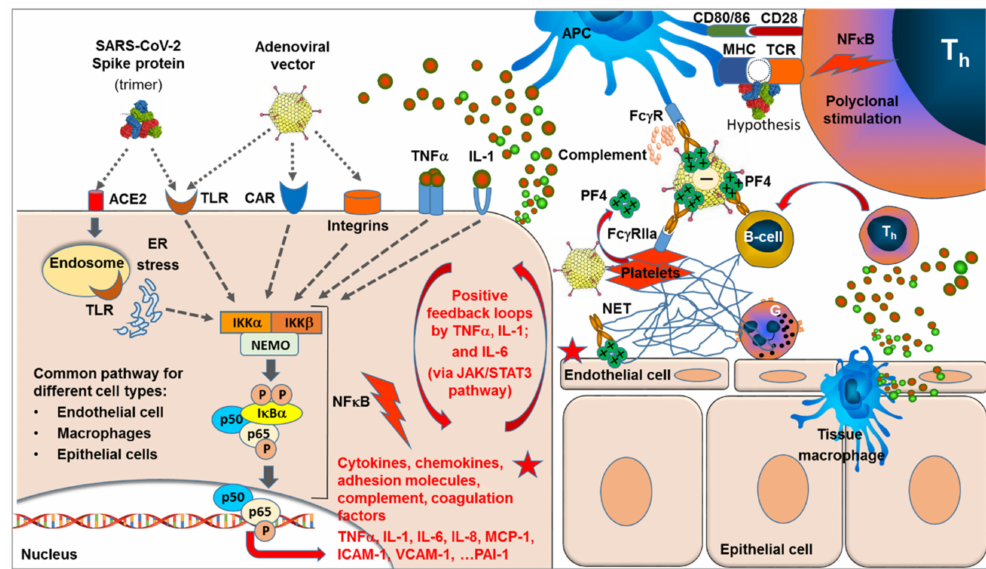
Figure 1. SARS-CoV-2 spike protein (expressed following vaccination with either mRNA or adenoviral vector) binds to the ACE2 receptor followed by endocytosis. Binding of the adenovirus (including replication defective E1/E3 deletion variants) occurs via binding of the fiber-knob to the CAR (coxsackie and adenovirus receptor), followed by interaction between the arginine-glycine-aspartate (RGD) motif within the viral penton base with the integrins on the cell surface. In addition both, SARS-CoV-2 and adenovirus bind and activate various Toll-like receptors (TLRs), leading to activation of the NF κ B signaling pathway, including activation of IKK complexes, release of p50/p65 complexes from the inhibitor complex with I κ Ba, and translocation of the phosphorylated p50/p65 heterocomplex to the nucleus, where the transcription of proinflammatory genes, including those for cytokines, such as TNF α , IL-1, and IL-6; chemokines, such as MCP-1 and MCP-3; adhesion molecules, such as ICAM-1 and VCAM-1; and complement components and coagulation factors, such as PAI-1, is induced. These processes are triggered in a broad variety of cell types that express the respective receptors, including epithelial cells, macrophages, and endothelial cells. Expression of TNF α and IL-1 and increased integrin expression can result in auto amplifying positive feedback loops, which may extend to other integrated systems such as complement and coagulation. Signaling of IL-6 via JAK/STAT3 pathway is expected to trigger additional amplifying loops. The release of chemokines, such as MCP-1 and IL-8, will attract the migration and accumulation of inflammatory and immune cells to the site. In particular, neutrophils are attracted, releasing DNA chromatin nets, i.e., NETs. While these events are known to accelerate and amplify in the case of massive viral infection by SARS-CoV-2, the localized expression of the spike protein in the case of vaccination was not expected to result in levels inducing a major systemic symptomatic picture. However, in the case of adenoviral vector vaccines, additive and synergistic effects are possible. In addition to additional activation of the NF κ B pathway, adenoviruses directly bind and activate platelets, which causes their activation/aggregation. Activation of platelets results in increased release of PF4—a tetramer with high positive surface charge—which can bind to the negatively charged glycosaminoglycan on endothelial cells. VITT-induced antibodies are induced by electrostatic binding of the positively charged PF4 tetramers to the negative surface of the adenoviral vector hexones forming highly immunogenic complexes, which trigger the formation of anti-PF4-directed antibodies. Binding of induced antibodies to the PF4-attached adenoviral surface facilitates uptake of these complexes via an Fc-gammaR-mediated process. Antigen presenting cells (APC) take up antibody-PF4 (adenovirus) complexes via different types of Fc-gamma receptors, resulting in cellular activation and complement activation. Additionally, platelets are able to bind such complexes via their FcgammaR2a receptor, resulting in further activation, release of PF4, aggregation of platelets, and thromboses. The supposed superantigen features of the spike protein may present an additional mechanism for accelerating the induction of anti-PF4 antibodies. Different from antigen-specific activation of single T-cell clones in the case of conventional antigens, with the antigen presented in the MHC-TCR groove, superantigens bind outside this groove to the MHC and/or TCR, resulting in polyclonal activation. Adapted from ref.